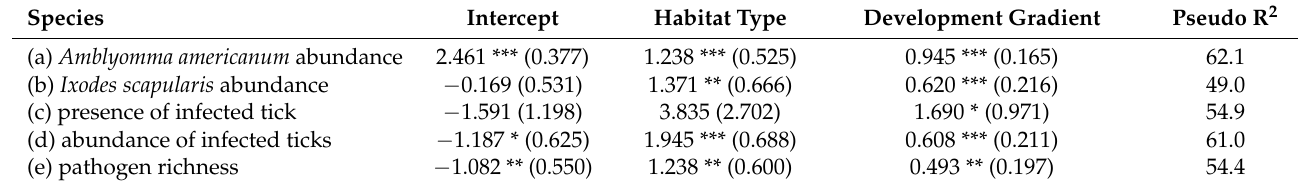
Table 5. Result of top GLM models evaluating the influence of landscape variables on tick abundance, infected tick presence and abundance, and pathogen richness for greenspaces in Alachua County, Florida, USA. Infected ticks were defined as nymphs or adults of any species of tick having a microorganism that was confirmed or potentially pathogenic (Table 2). The top GLMs (lowest AIC) for (a) Amblyomma americanum abundance, (b) Ixodes scapularis abundance, (c) presence of infected ticks of either species, (d) abundance of all ticks, and (c) pathogen richness are reported. The development gradient represented the developed-to-natural landcover gradient, using 500 m buffers for each site. The standard error for each estimate is indicated in parentheses. Complete model results are presented in Supplementary Tables S4 and S6. *** indicates p < 0.01; ** indicates p < 0.05; * indicates p < 0.1.